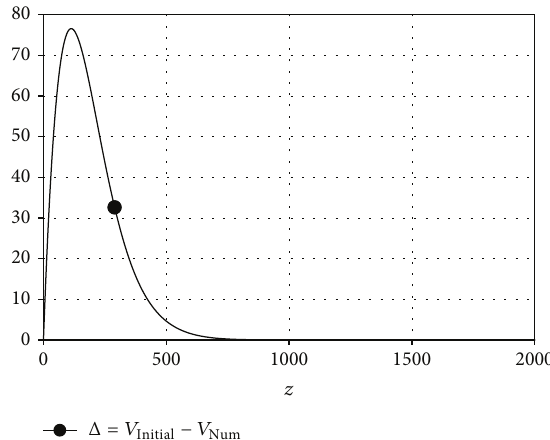
Figure 9: The difference Δ between the initial approximation 𝑉 and numerical solution 𝑉 Num